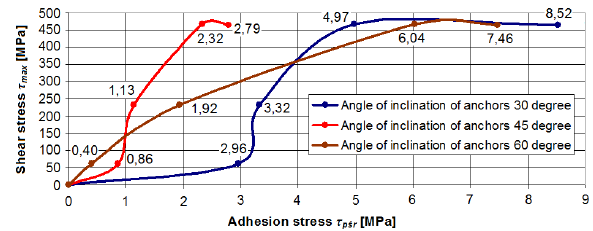
Figure 14: Dependency shear stress – adhesion stress for M8 ÷ M30 anchors in slab long under-window.